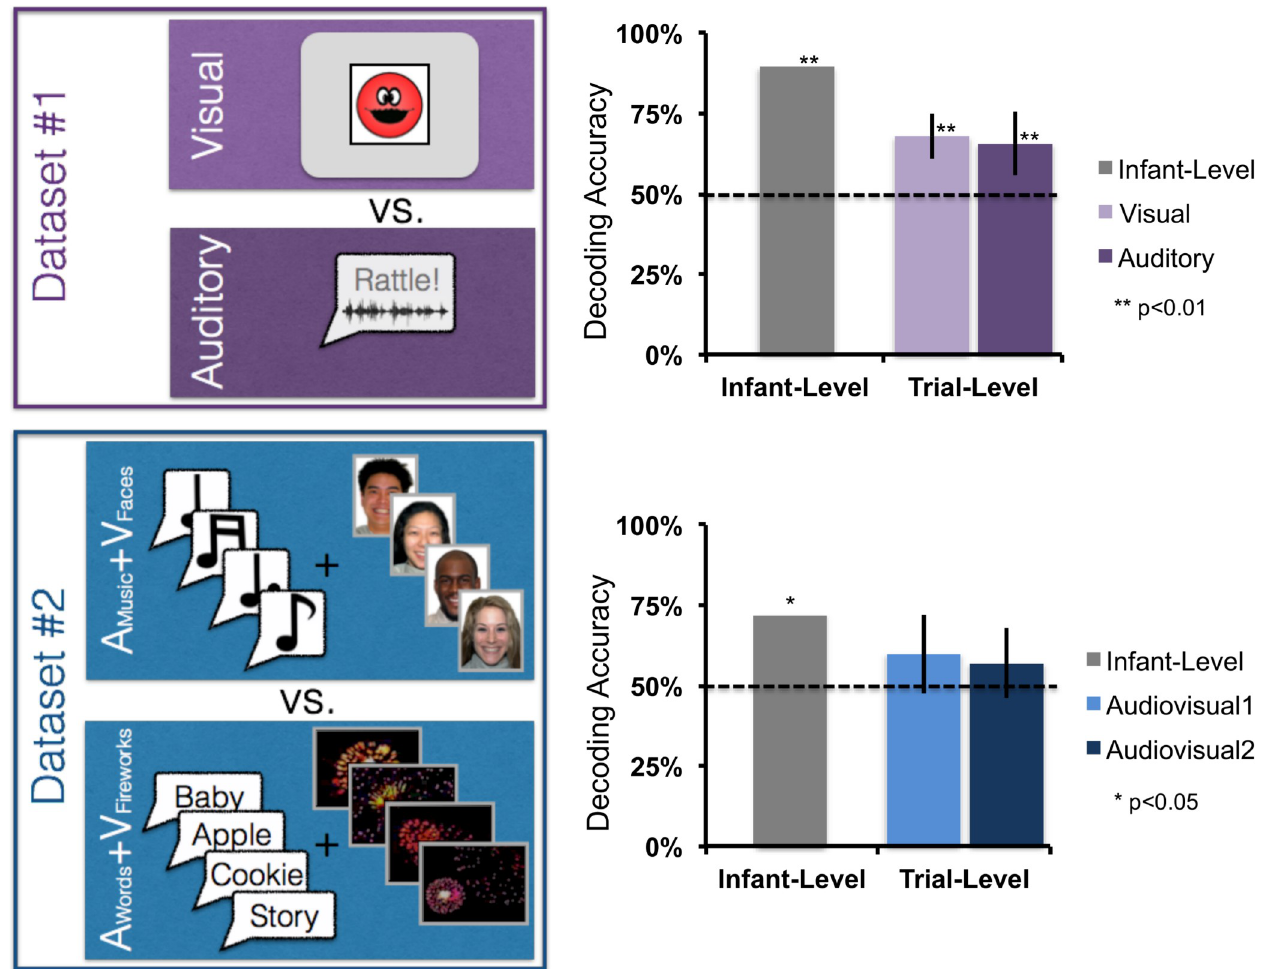
Fig 3. Depiction of the two datasetsand the decoding results (infant-level and trial-level) for each. Error bars depict the bootstrapped confidenceintervals of the mean across infants.